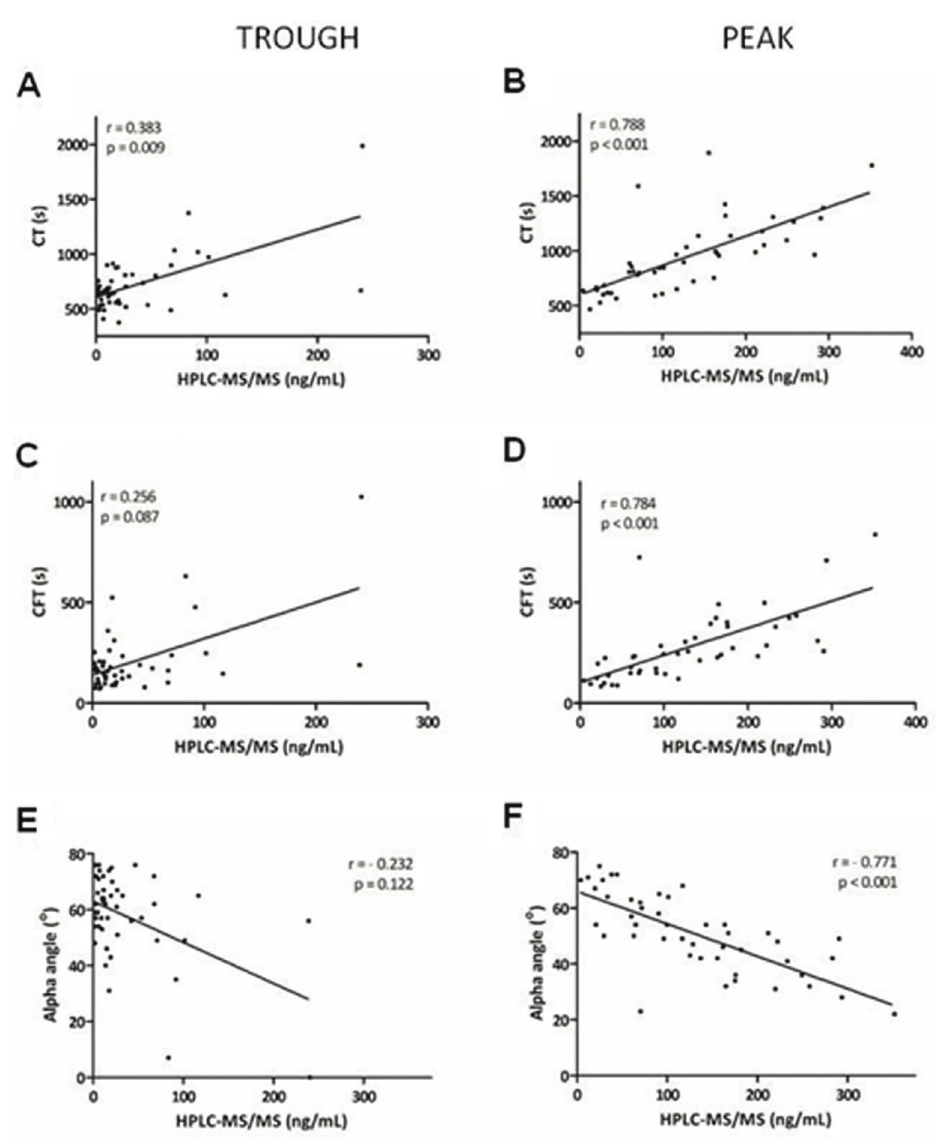
Figure 2. Correlation between high-performance liquid chromatography tandem mass spectrometry (HPLC-MS/MS) and thrombo- elastometry differentiating trough and peak for clotting time (CT) ( A and B ), clot formation time (CFT) ( C and D ), and alpha angle ( E and F )